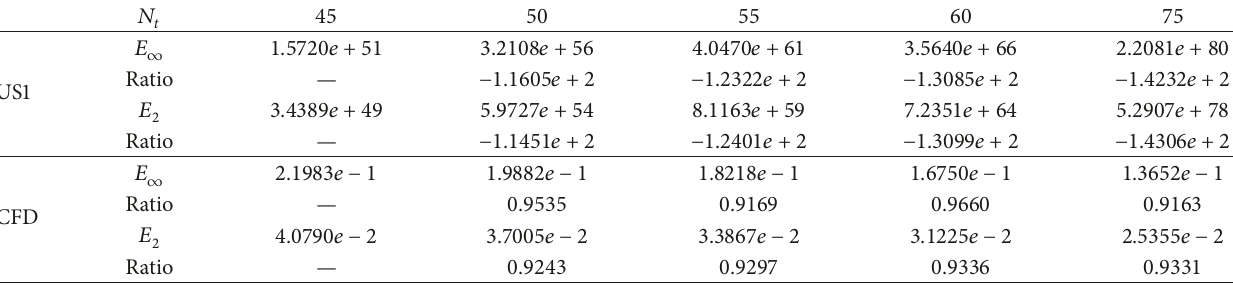
Table 1: Errors and ratios in time of the characteristic finite difference scheme (CFD) and the first-order upwind scheme (US1) using small space step of ℎ = 1/200 .